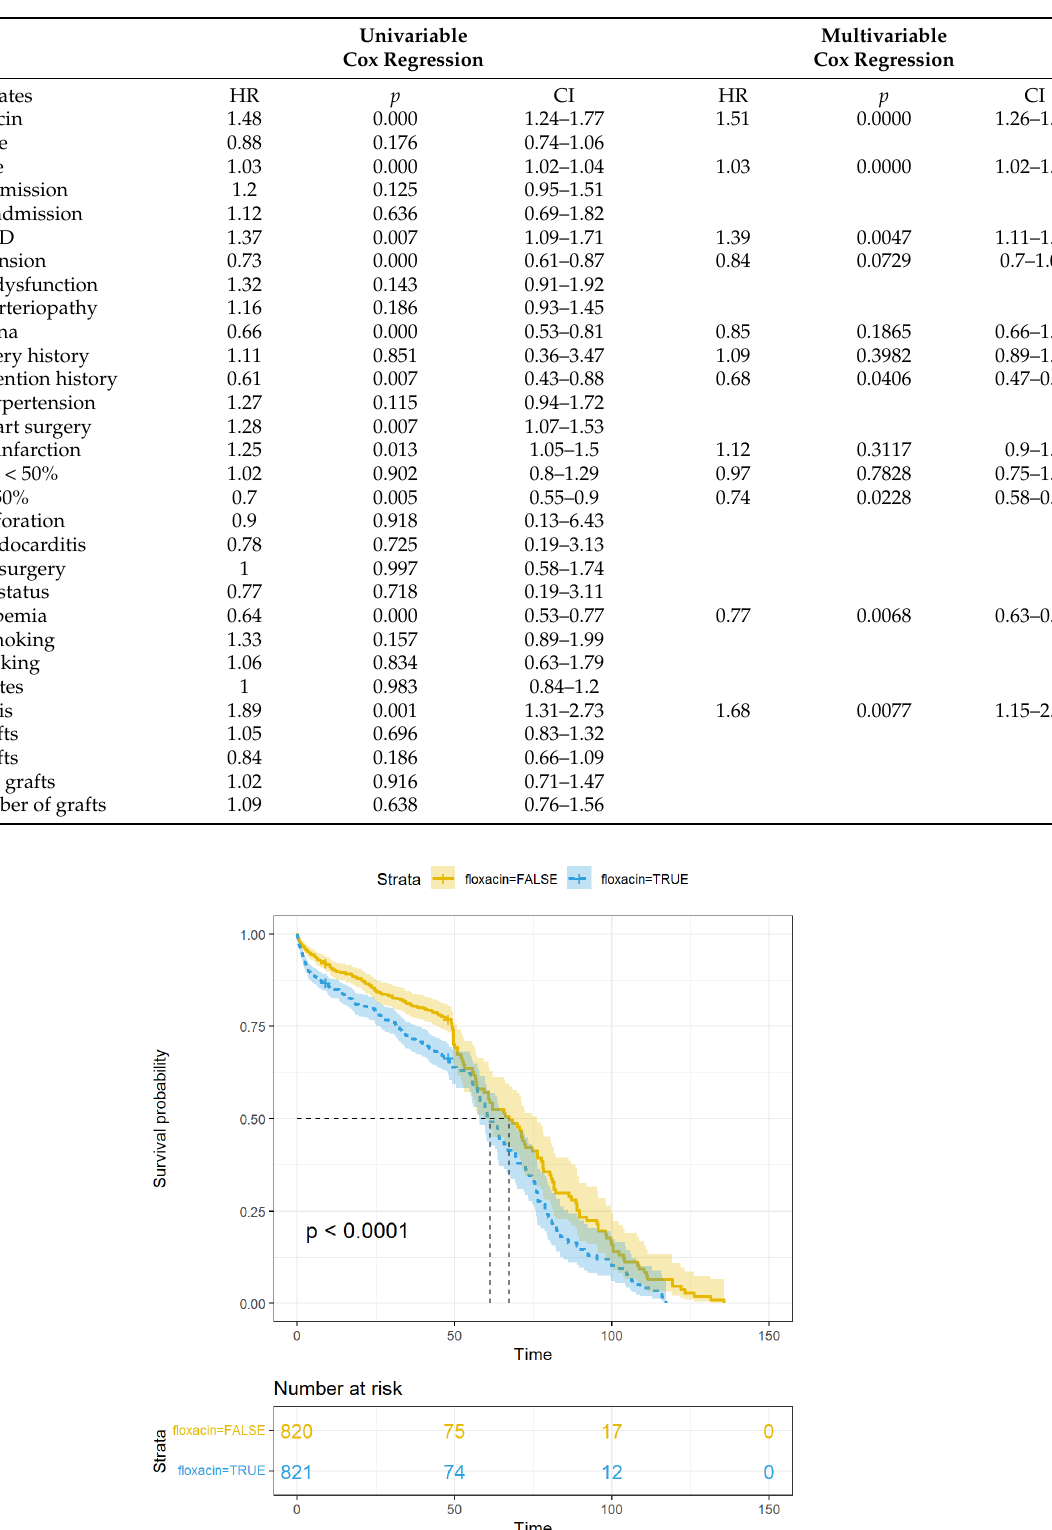
Table 3. Cox regression in matched cohort (Covariates with a p value no more than 0.05 were included for multi-regression).